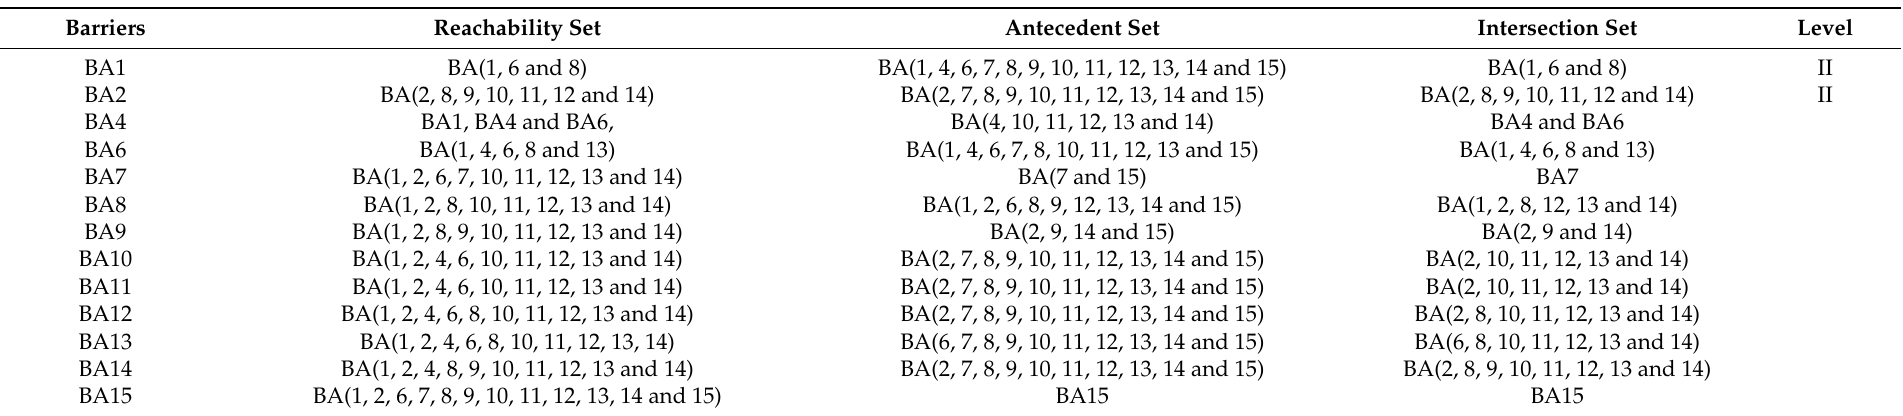
Table 10. Level II partition of the hierarchical structure of the barriers using a final reachability